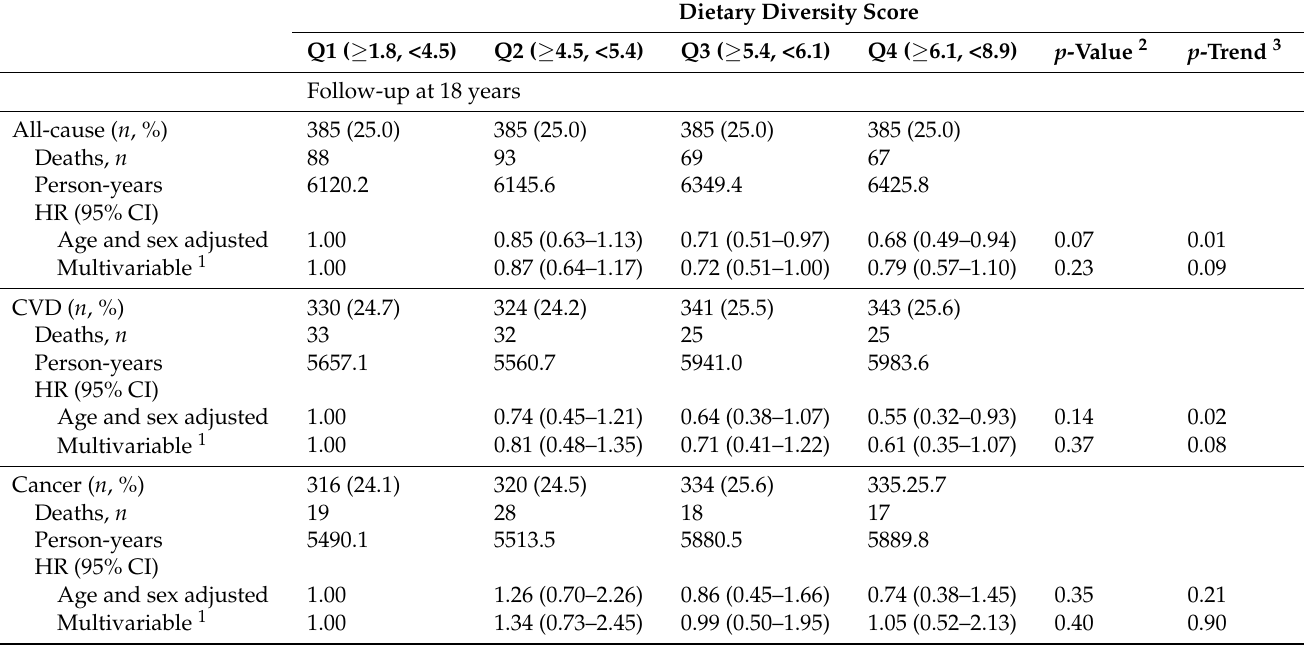
Table 3. Associations between dietary diversity score and all-cause, cardiovascular disease and cancer mortality among participants of the Valencia Nutrition Study in Spain ( n = 1540). Dietary Diversity